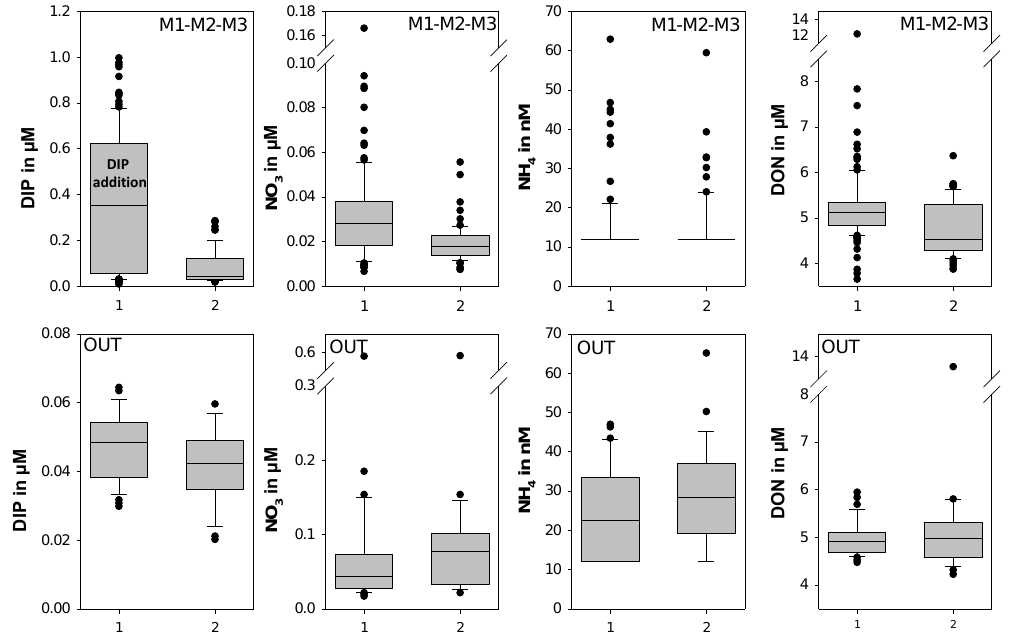
Figure 13. Box plots of nutrients, DIP, NO 3 , DON in µM and NH + (bottom panels) during the two periods P1 and